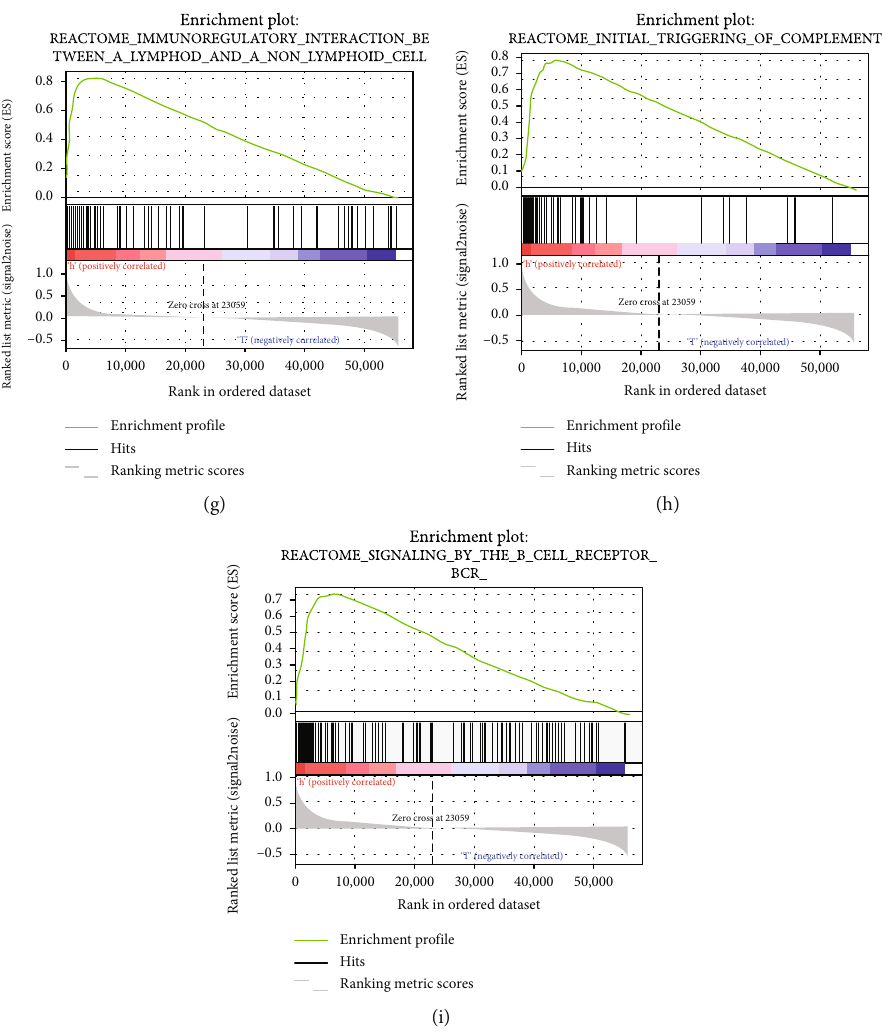
Figure 7: GSEA. (a) Adherens junctions interactions. (b) Antigen activates B cell receptor BCR leading to generation of second messengers. (c) Complement cascade. (d) Costimulation by the CD28 family. (e) Creation of C4 and C2 activators. (f) FGFR1 ligand binding and activation. (g) Immunoregulatory interactions between a Lymphoid and a non-Lymphoid cell. (h) Initial triggering of complement. (i) Signaling by the B cell receptor